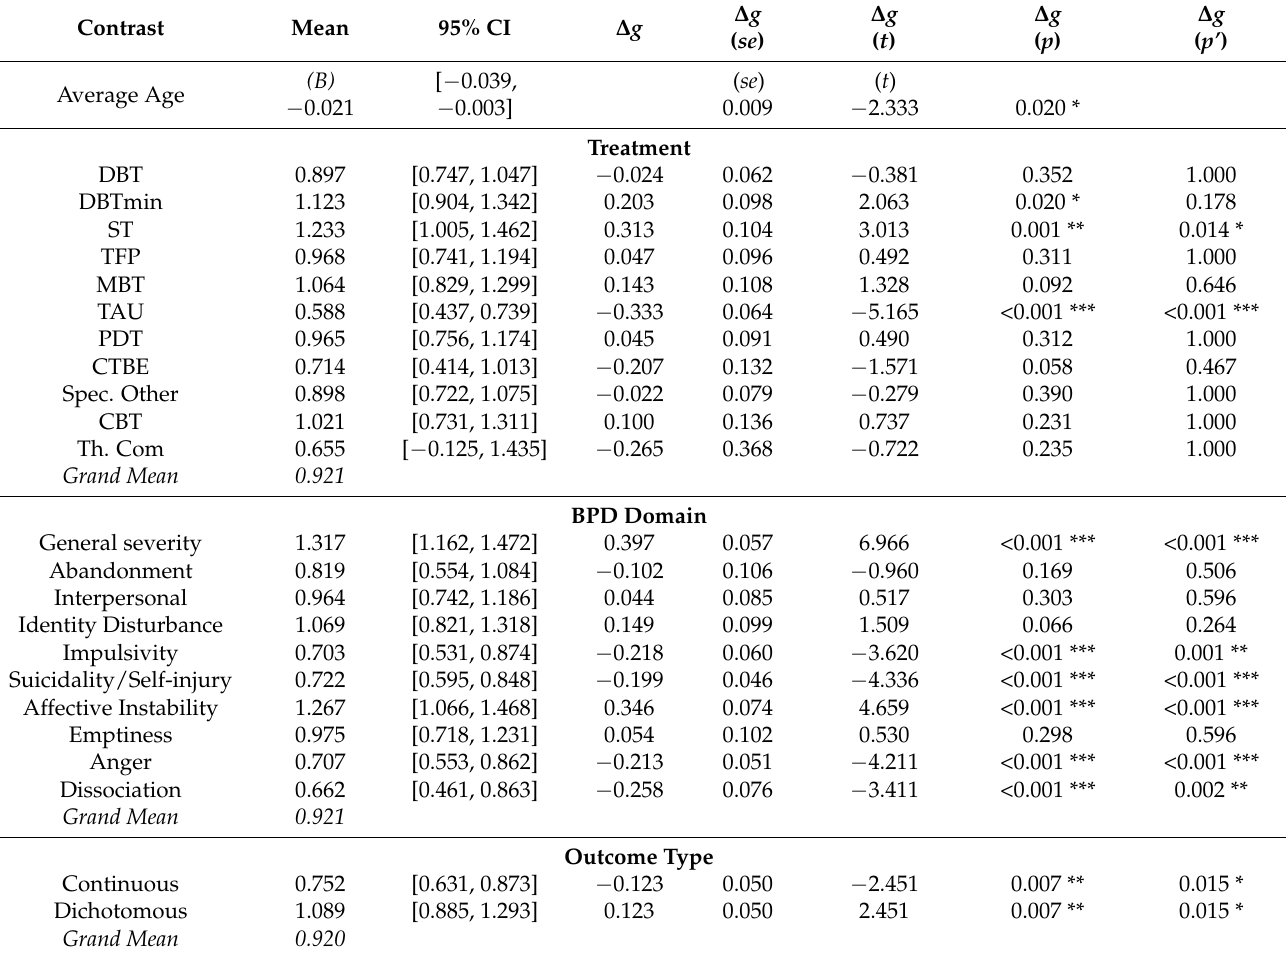
Table 2. Results of All Deviation Contrasts of the Transformed Effect